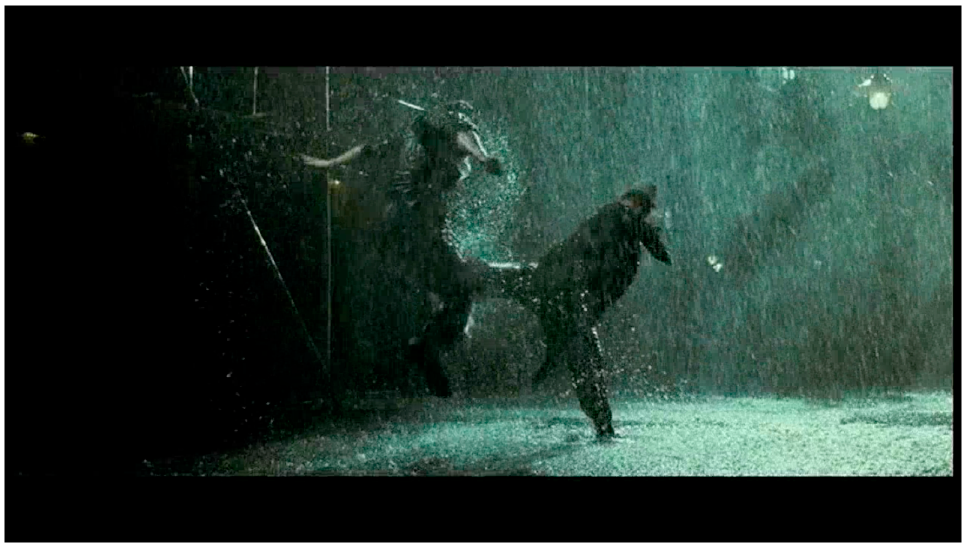
Figure 14. Fighters lose their solidity. Frame capture, The Grandmaster (Wong 2013). Arts 2017 , 6 , 19